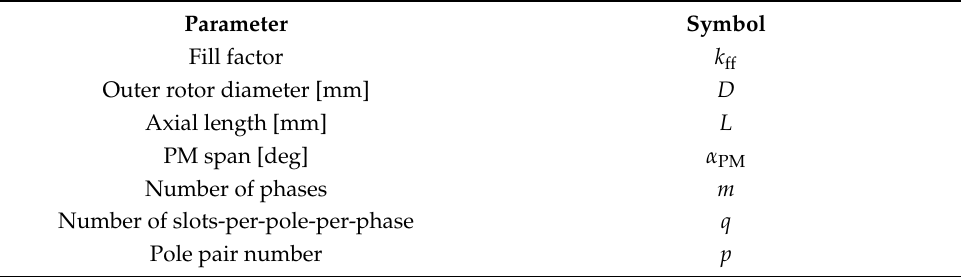
Table 3. Cont. Parameter Symbol Fill factor k ff Outer rotor diameter [mm] D Axial length [mm] L PM span [deg] α PM Number of phases m Number of slots-per-pole-per-phase q Pole pair number